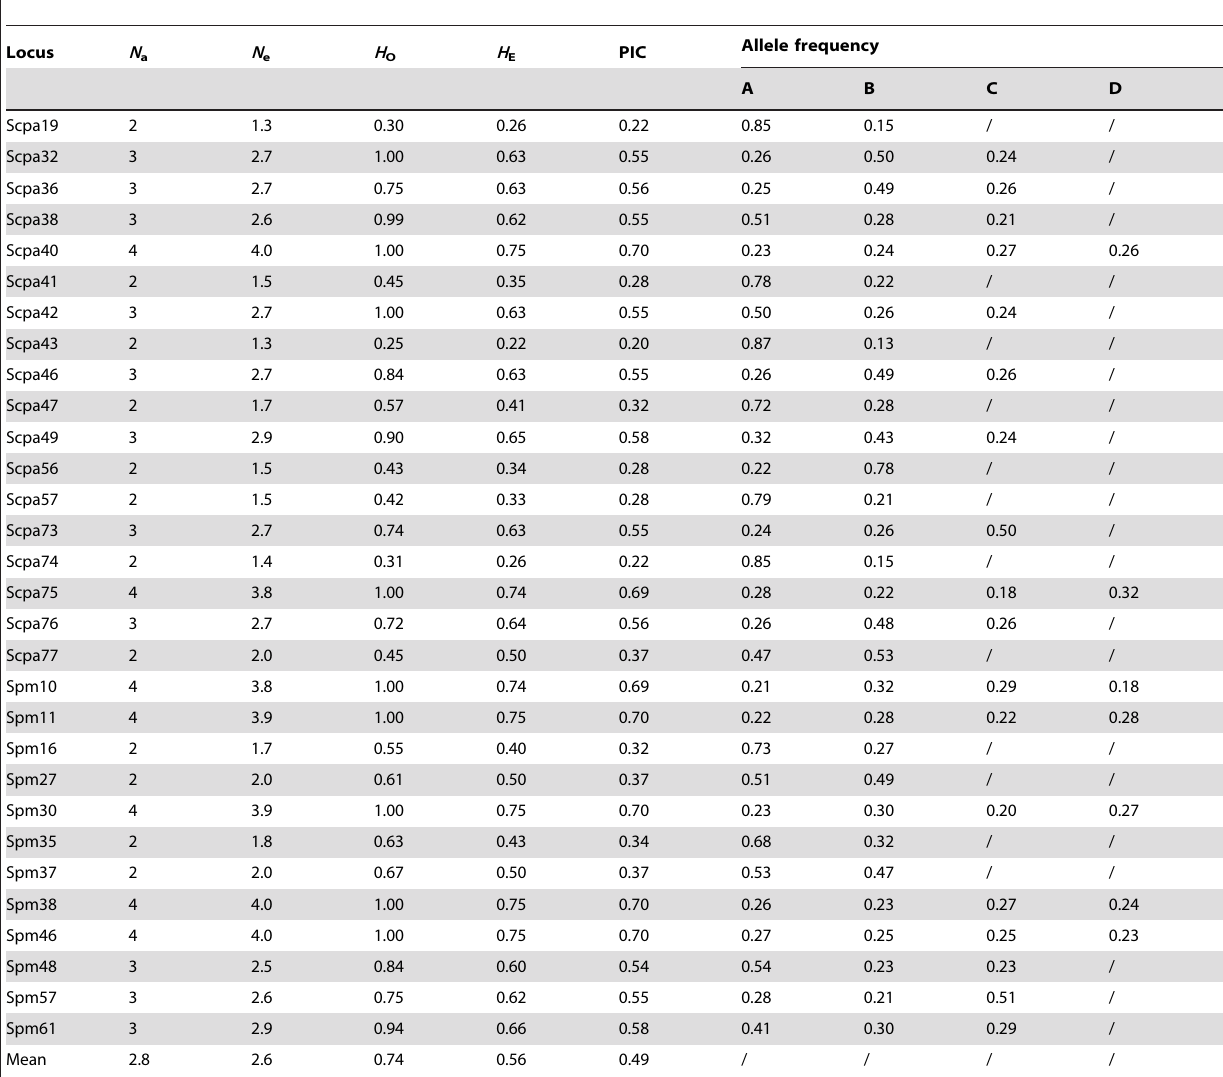
Table 1. Genetic variation of 30 microsatellite markers in G 1 family of S. paramamosain.